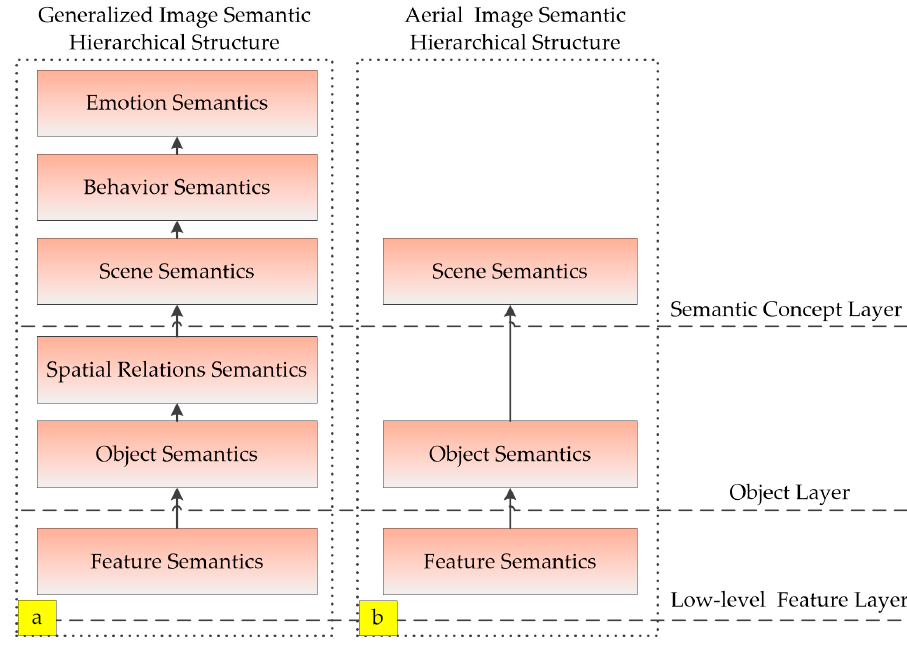
Figure 1. Image semantic hierarchical structure: ( a ) generalized image semantic hierarchical structure; and ( b ) aerial image semantic hierarchical structure.